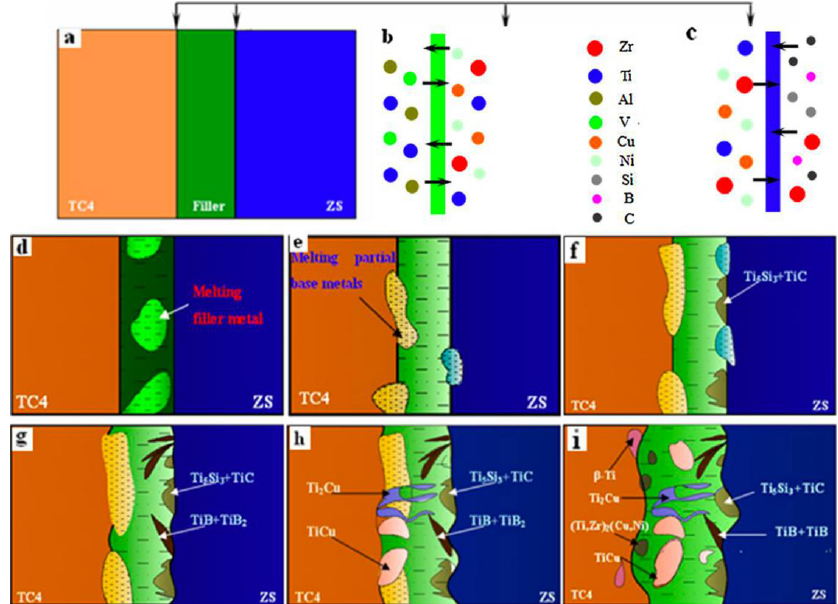
Figure 14. Schematic of the formation of each reaction layer during the brazing process: ( a – c ) show the interaction between filler and base metal; ( d ) the filler begins to melt; ( e ) the molten brazing alloy wetted the surface of base metals; ( f ) the formation of Ti 5 Si 3 and TiC; ( g ) the formation of TiB and TiB 2 ; ( h ) the formation of Ti 2 Cu and TiCu; ( i ) the formation of (Ti,Zr) 2 (Cu,Ni) and β -Ti during the cooling process, reproduced from Reference [39] with permission of Elsevier, 2017.